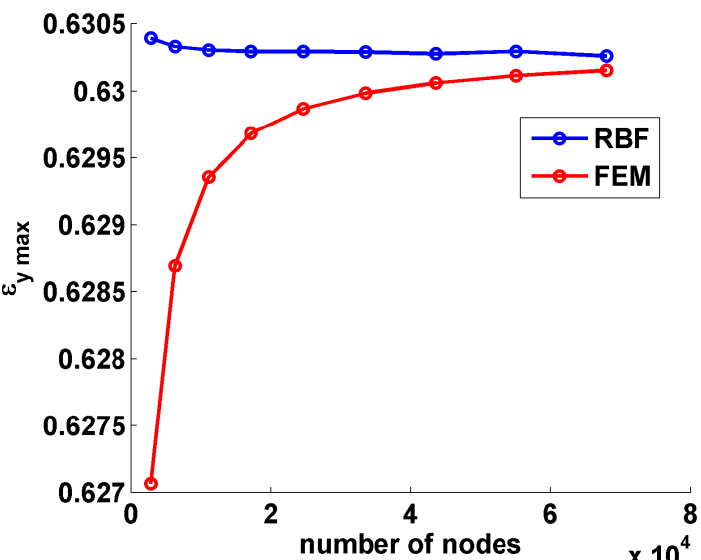
Figure 4. Convergence trends for the RBF post-processing method (blue) and FEM (red) on the mesh refined near the hole.